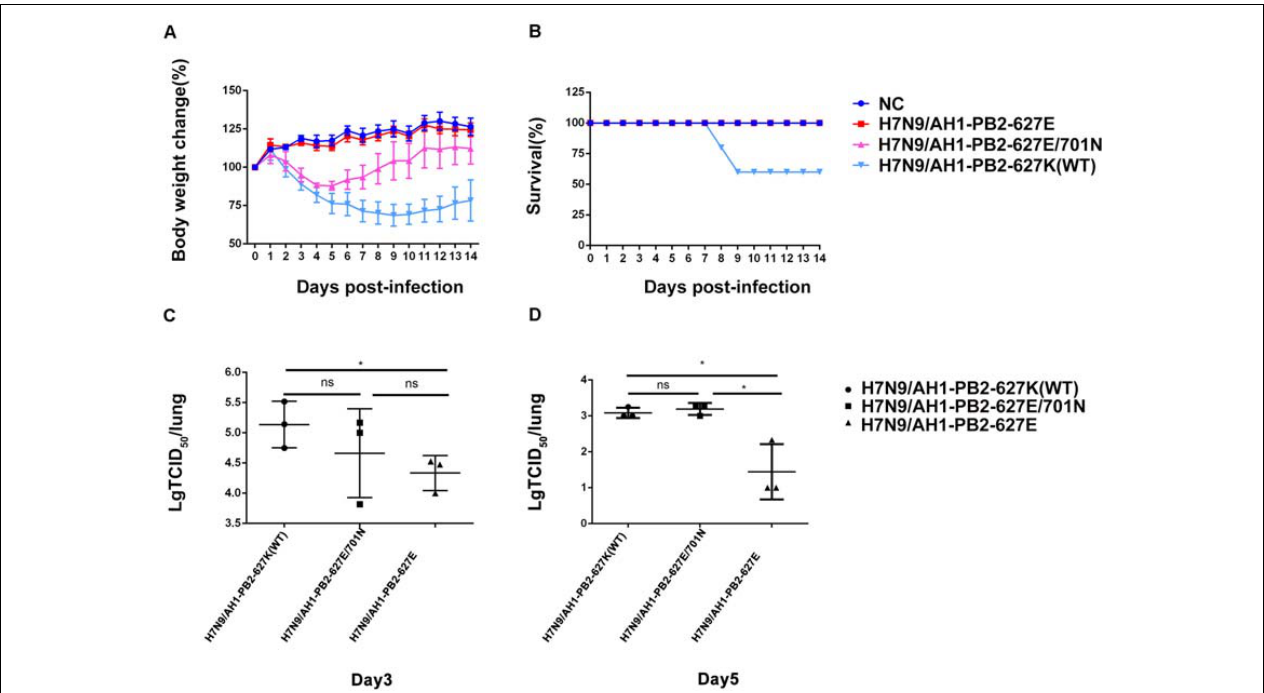
FIGURE 2 | Pathogenicity analysis of mice infected with H7N9/AH1-PB2-627K(WT) and its mutant viruses. Four mice per group were inoculated intranasally with the indicated doses of three virus and monitored for survival rate (A) and body weight changes (B) for 14 days. The viral titers of homogenized lung tissue on day 3 post-infection (C) and day 5 post-infection (D) of all three infected groups were measured by TCID50. The results shown are means ± standard deviations (SD) ( n = 3) (error bars) from three individual